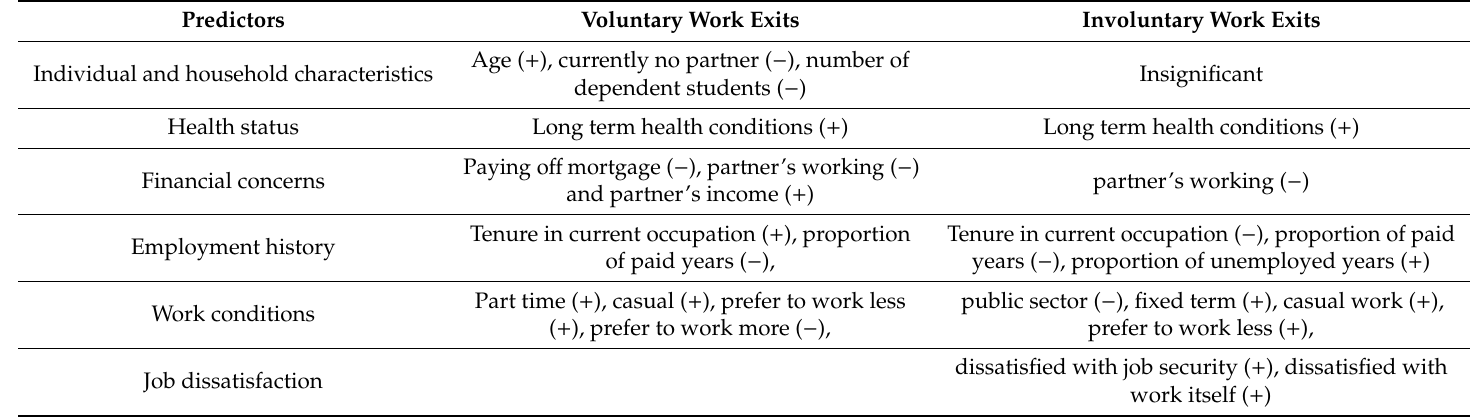
Table 4. Summary of significant predictors of voluntary and involuntary work